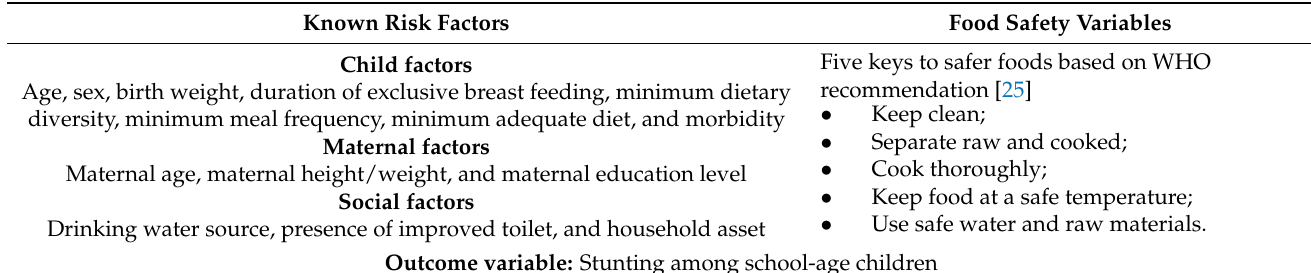
Table 1. Variables of interest.